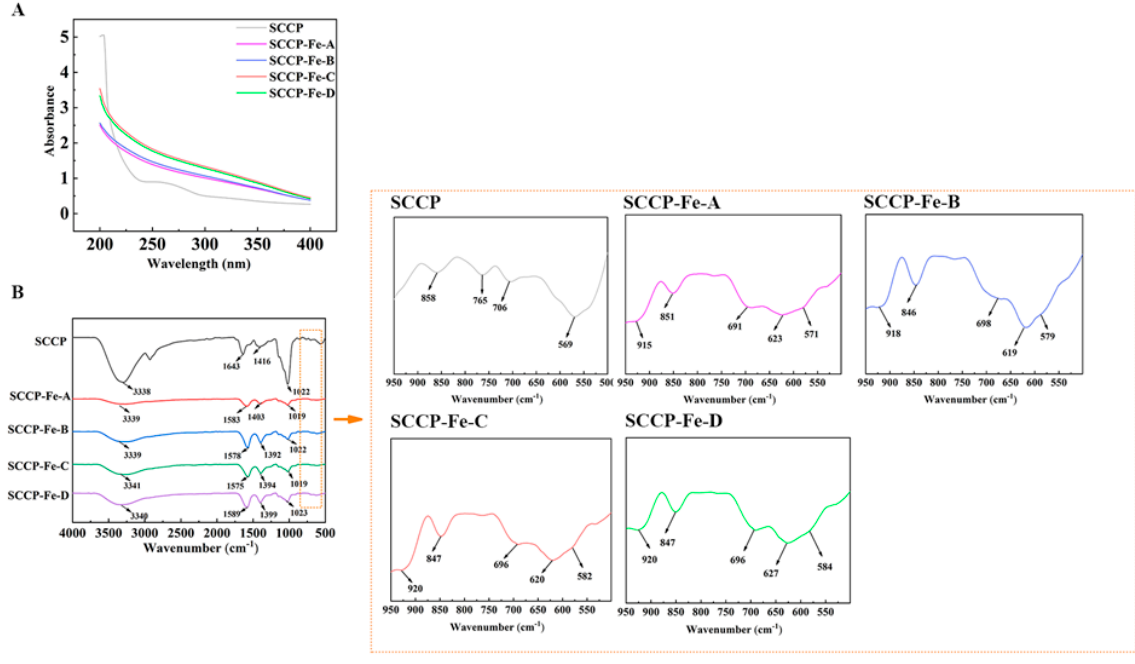
Figure 2. UV-vis ( A ) and FT-IR spectrum ( B ) of four sweet corn cob polysaccharide-iron (III) com-